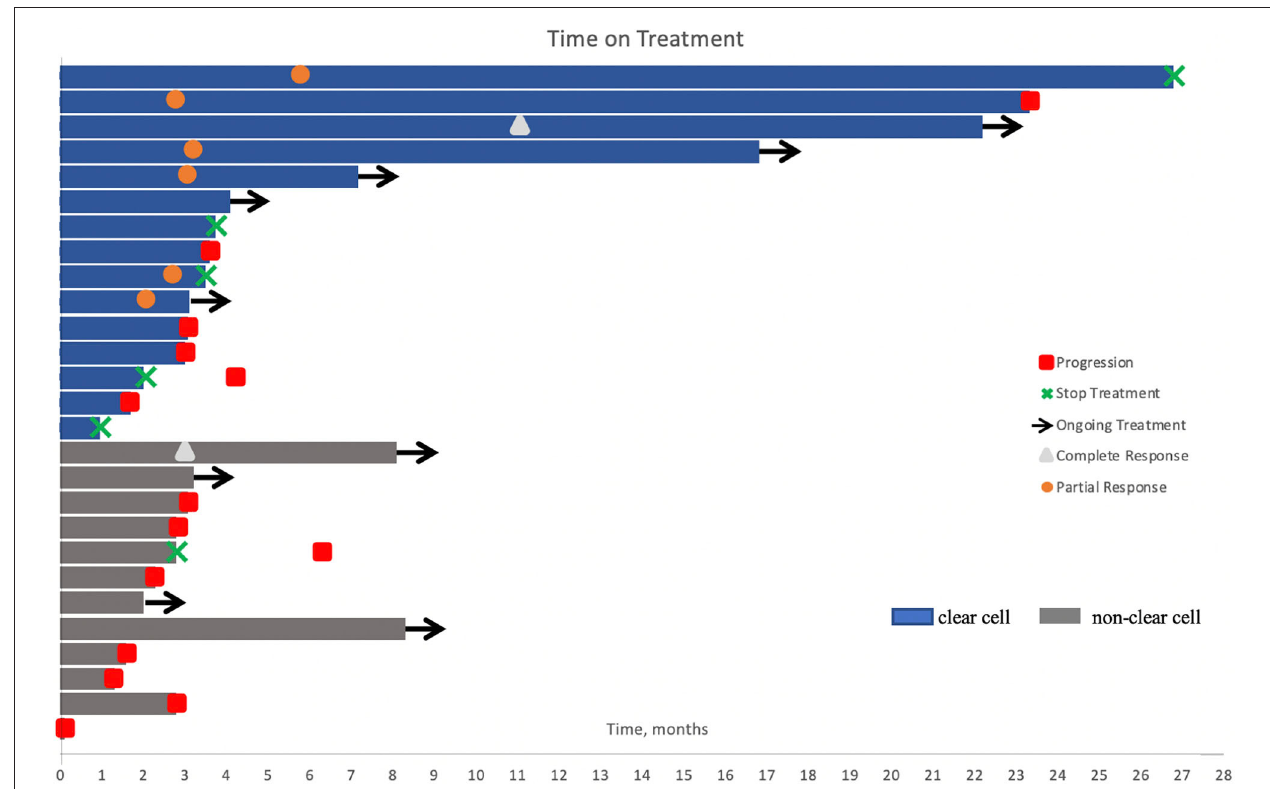
FIGURE 1 | Swimmer’s plot of time on treatment for the study cohort ( n = 27). One patient received a single dose of immunotherapy. Nine patients were still on treatment at the time of analysis. Six patients had stable disease, including one patient with papillary RCC where axitinib was added to his treatment regimen after three cycles of pembrolizumab. Treatment was held or permanently discontinued in five patients due to adverse events and in one patient after 2 years of treatment.